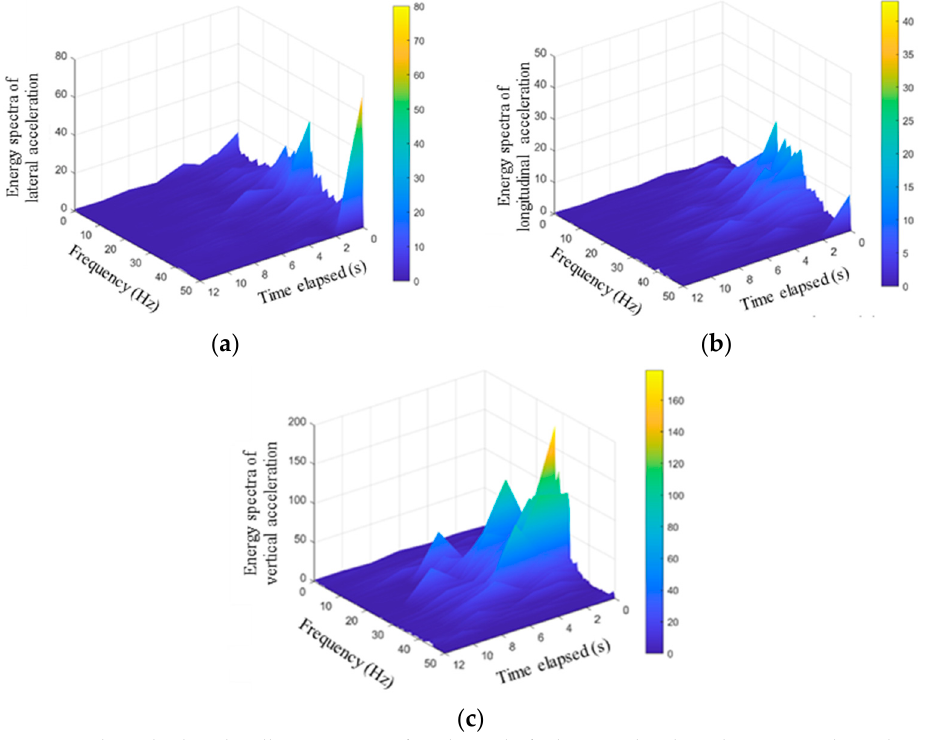
Figure 14. The calculated Hilbert spectra of ( a ) lateral, ( b ) longitudinal, and ( c ) vertical acceleration responses recorded by #R1 during tamping operation